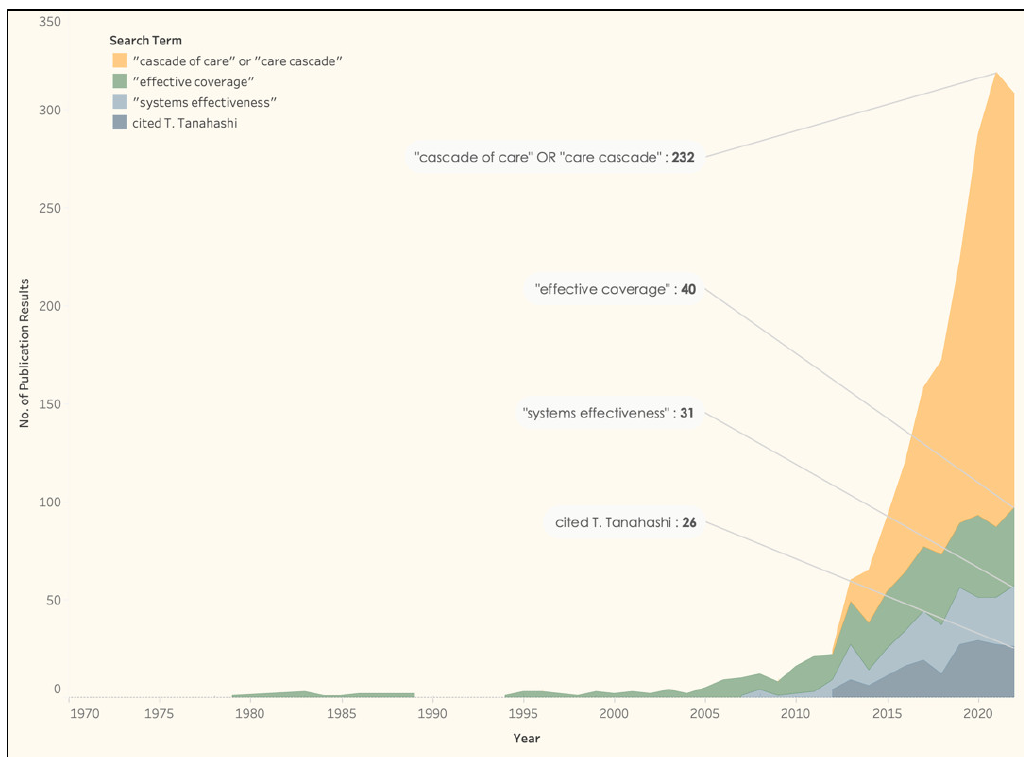
Figure 1. Frequency of publications relevant to effective coverage by 5-year periods since 1975. Citations of T. Tanahashi are publications referencing the landmark paper “Health Service Coverage and its Evaluation” Bull World Health Organisation 1978, 56, 295–303. Publications are indexed by PubMed as of 13 December 2022. Some results may overlap.